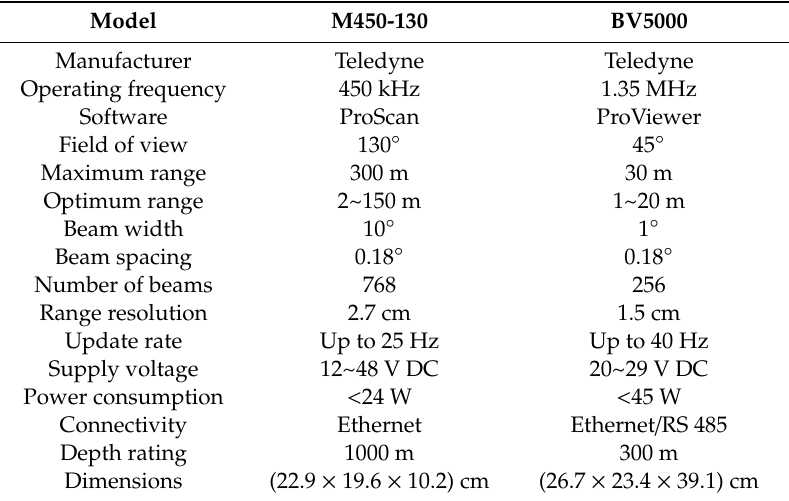
Table 1. The specifications of two sonar instruments.